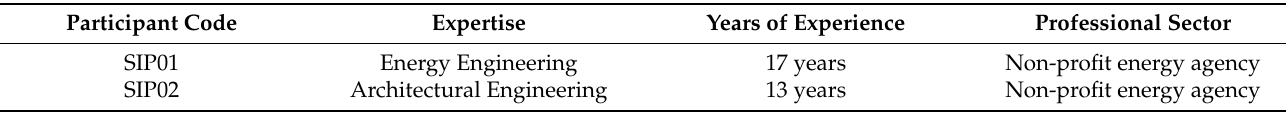
Table 5. Interview participant